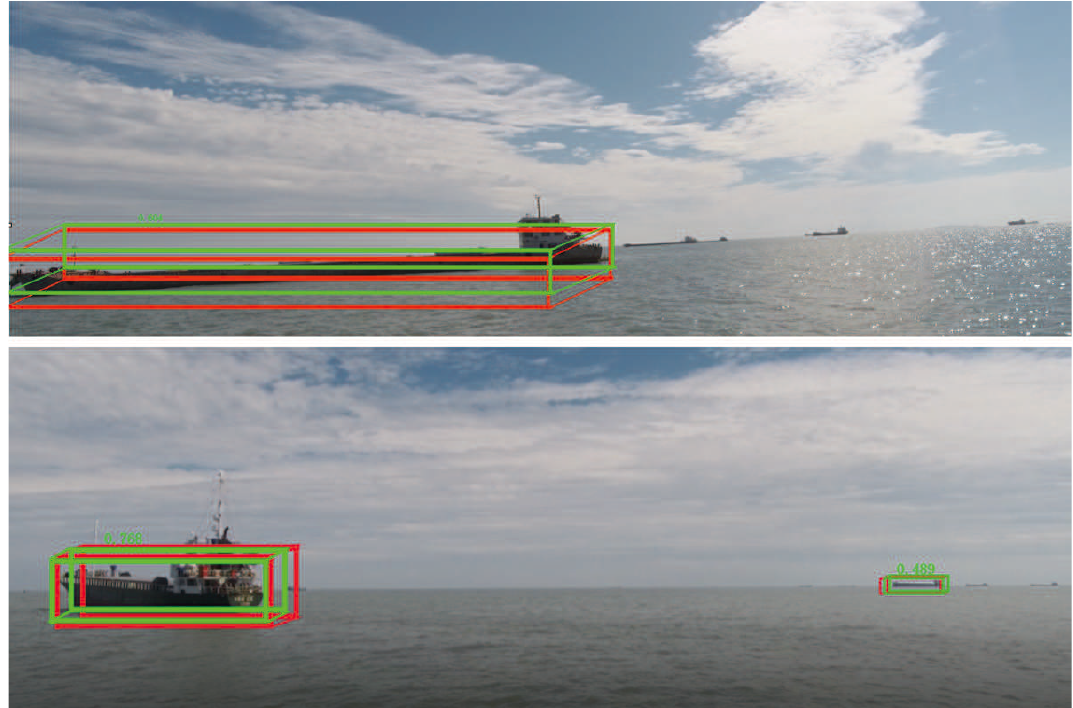
Figure 9. Quality of 3D detection